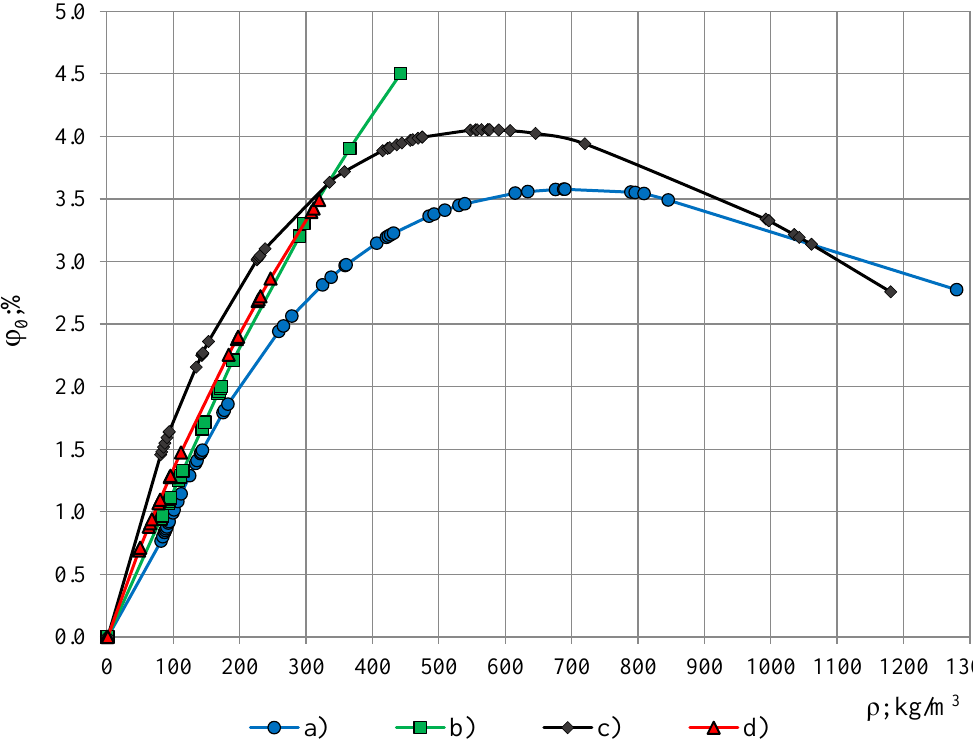
Figure 9. Dropping factor in dependence of PUR foams’ density: (a) lab-made foams, (b) lab-made biofoams, (c) Sika JSC foams and (d) General Plastics Manufacturing Company foams.